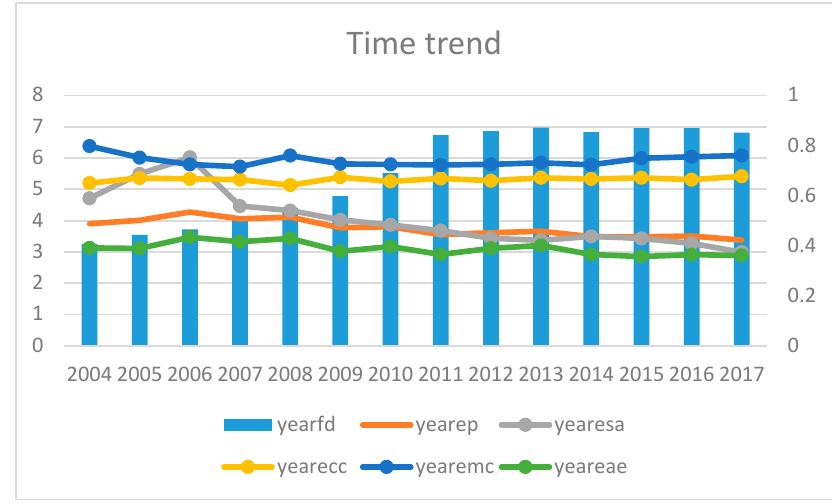
Figure 2. The trends for average energy poverty and average fiscal decentralization. Table 3. Cross-sectional dependence test results.